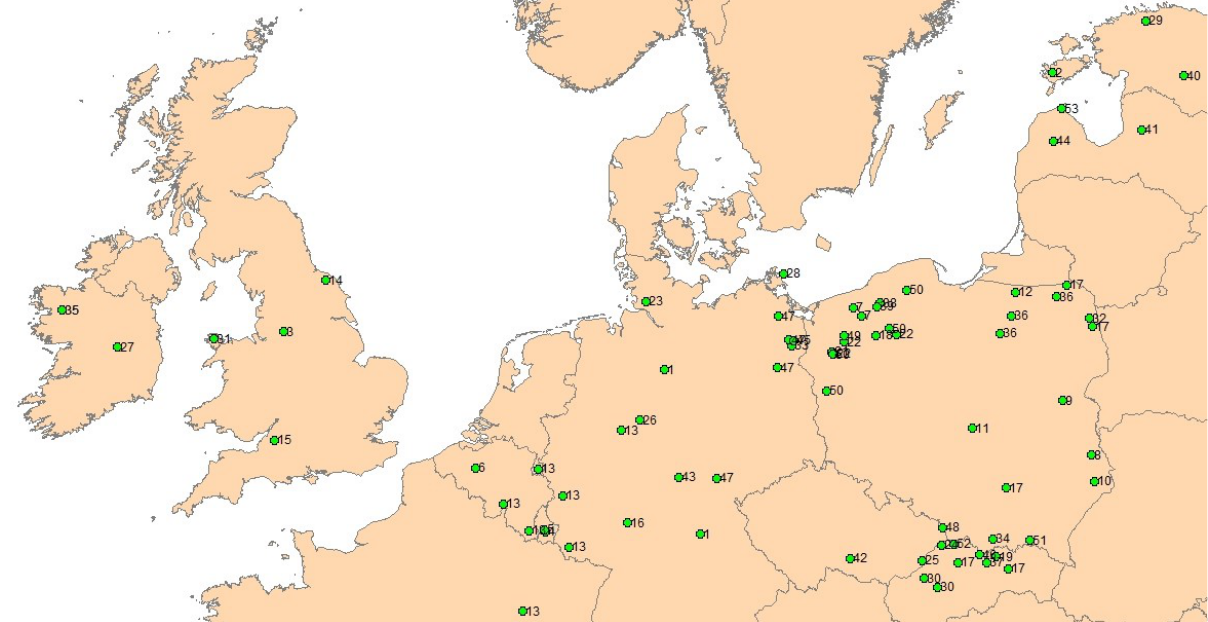
Figure 2. Occurrence and references of Petrifying-springs and Calcareous-spring-mire sites discussed in the current study. 1 - Arp et al . 2010; 2 - Blaus et al . 2020; 3 - Columbu et al . 2013; 4 - Couteaux